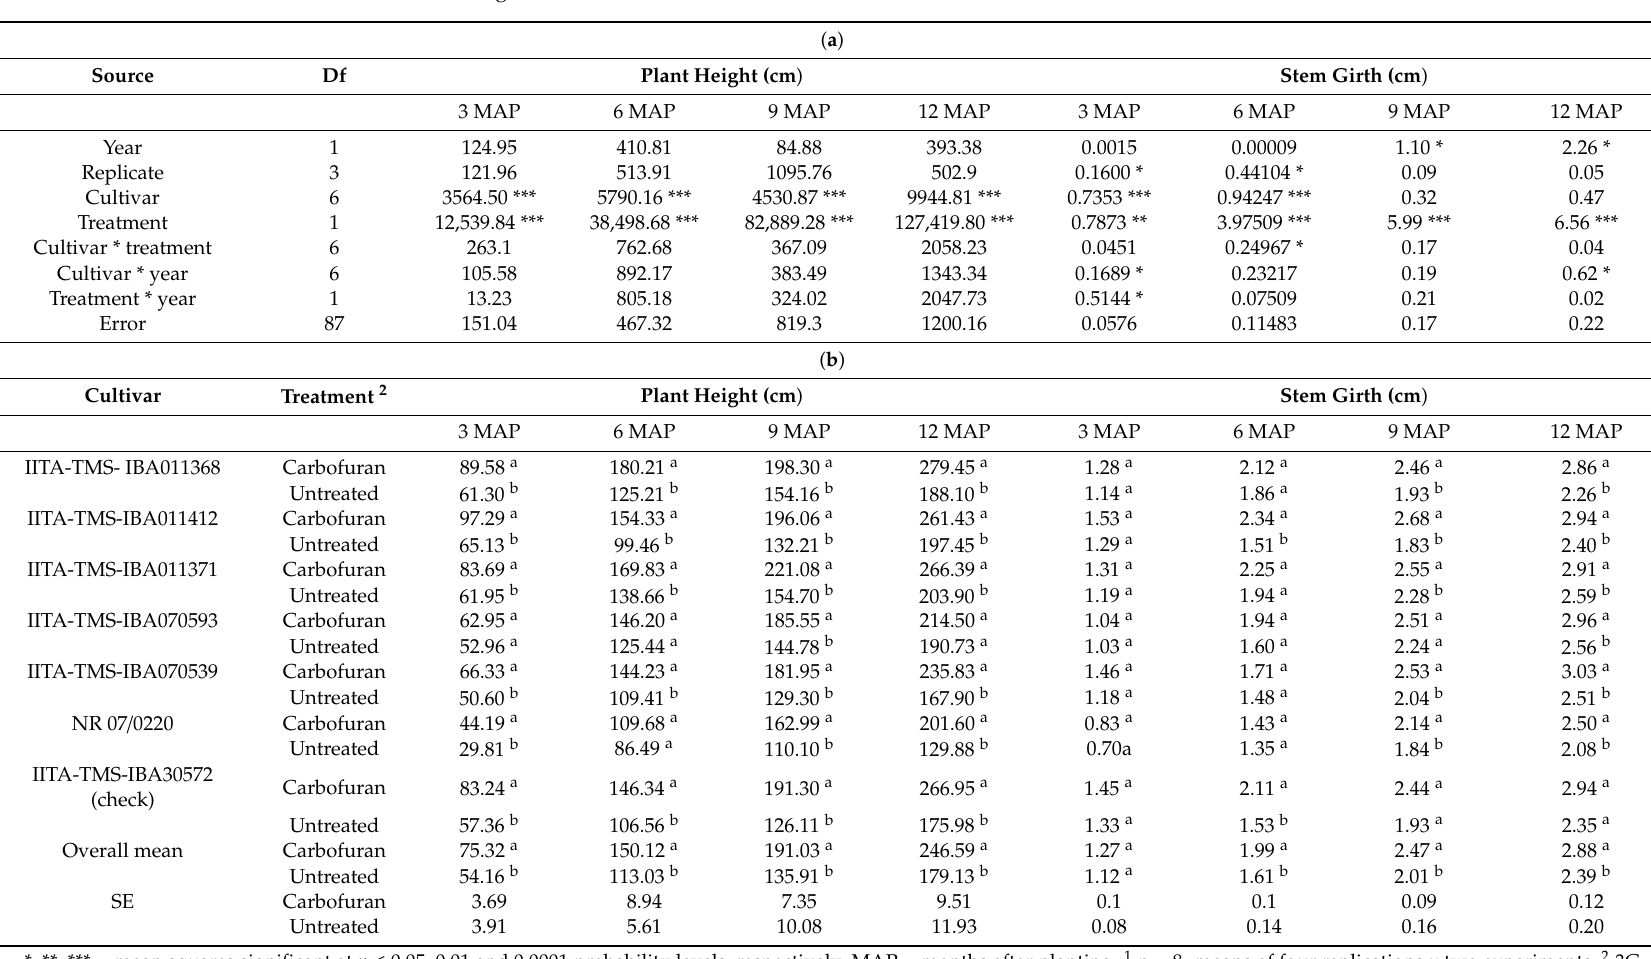
Table 3. ( a ). Mean squares for growth and development of six biofortified cassava and one white cultivar in field trials in Nigeria. ( b ) Growth and development of six biofortified cassava cultivars in field trials in Nigeria 1